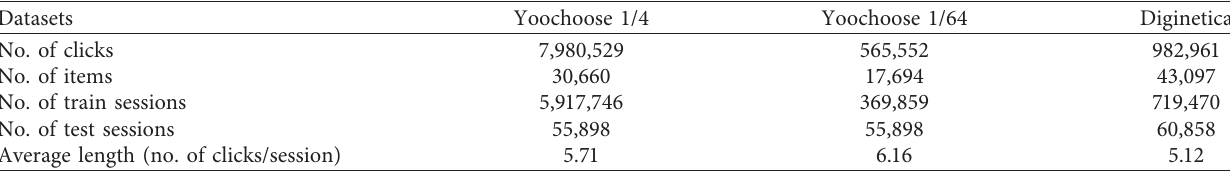
Table 1: The statistics of the datasets.